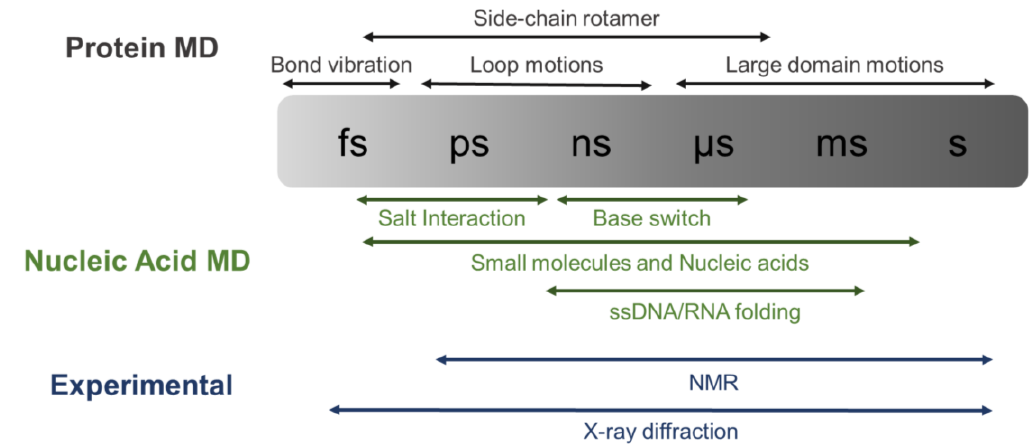
Figure 1. Timescale defines what can be observed by molecular dynamics simulation. The timescale of dynamic processes in proteins (Black), protein – nucleic acid complexes (Green), and the experimental methods (Blue) that can be observed from the different methods.